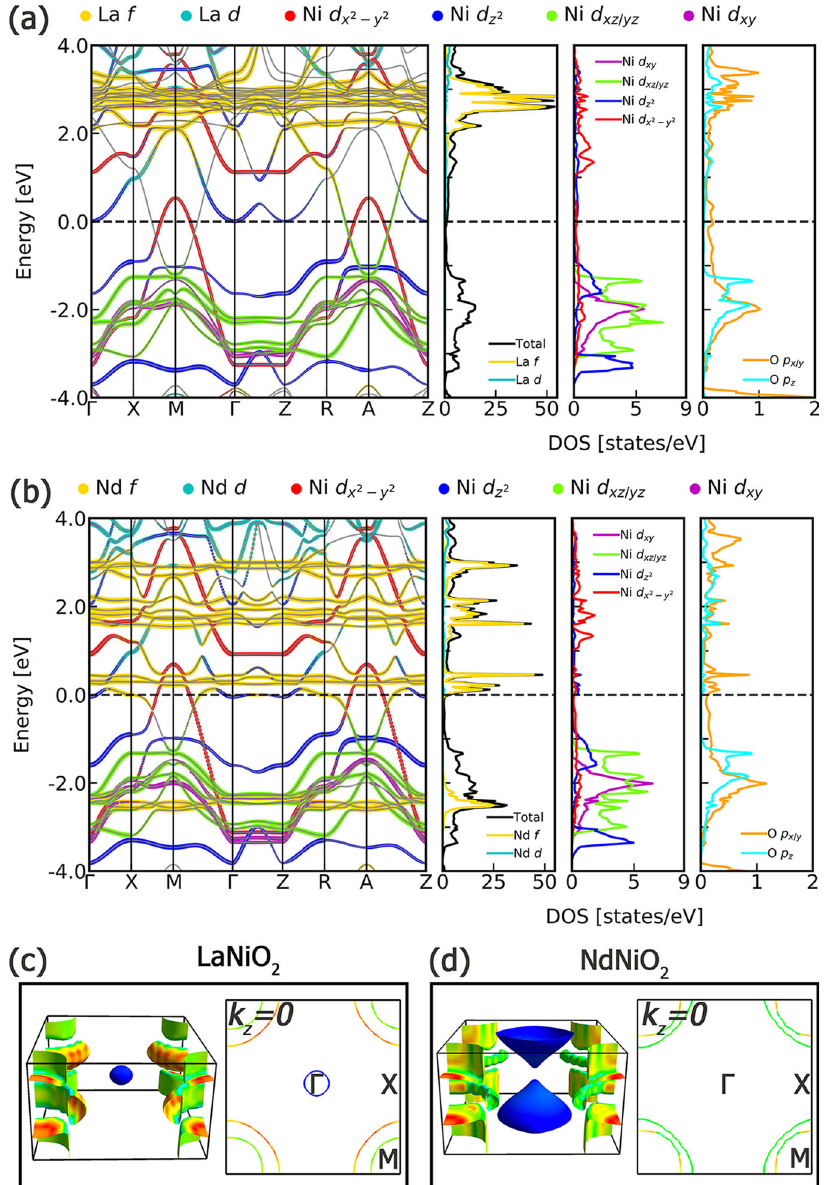
Fig. 6 The calculated electronic structures and Fermi surfaces of A -type antiferromagnetic ( A -AFM) phase. Orbitally-projected electronic structures of the A -AFM phase of a LaNiO 2 and b NdNiO 2 . Band structures are unfolded to the primitive 1 × 1 × 1 Brillouin zone. c The calculated Fermi surface of LaNiO 2 and the projection of the Fermi surface on the k z = 0 plane. d Same as c but for NdNiO 2 . Red and blue colors identify portions of the Fermi surface where the Fermi velocity is maximum and minimum, respectively. The Fermi velocity lies in-between the maxima and minima in the green